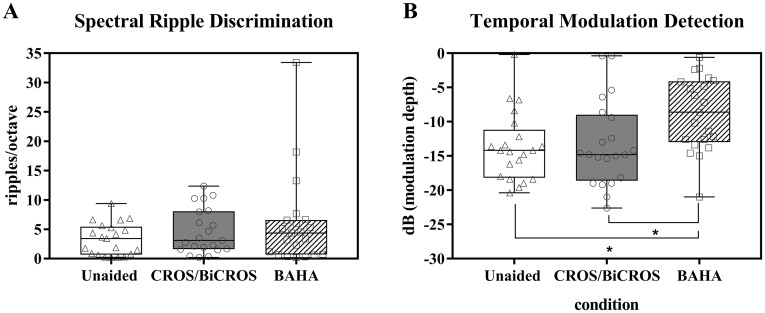
Psychoacoustic performance.SRD thresholds (A) and TMD thresholds (B) are shown for the three listening conditions. For the SRD test, a higher detection threshold indicates better SMD performance. For the TMD test, a more negative detection threshold implies better TMD performance. An asterisk (*) indicates a significant difference between two groups in post-hoc analysis (p-value was 0.05/3 based on Bonferroni correction).